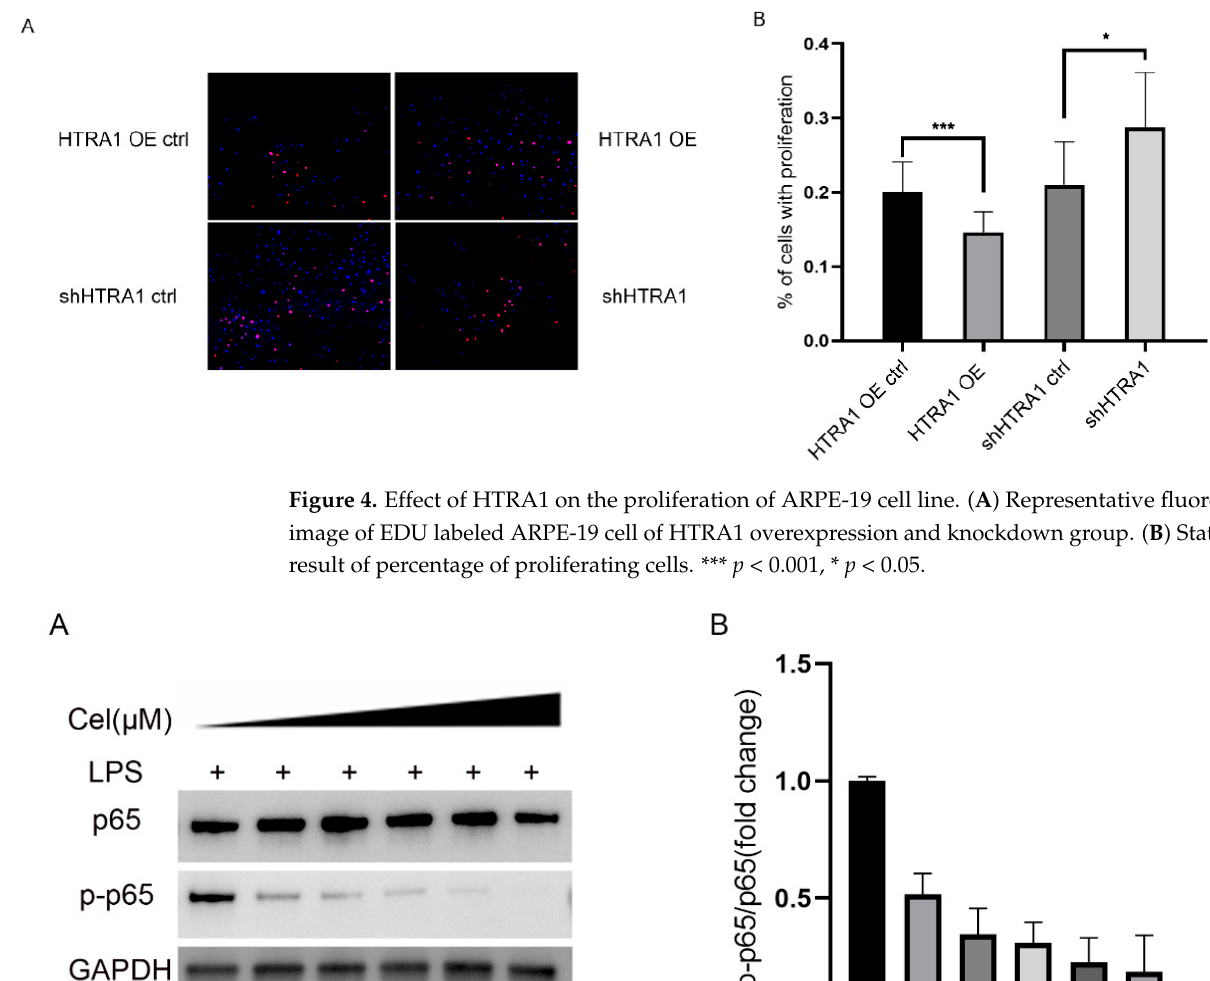
Figure 4. Effect of HTRA1 on the proliferation of ARPE-19 cell line. ( A ) Representative fluorescent image of EDU labeled ARPE-19 cell of HTRA1 overexpression and knockdown group. ( B ) Statisti- cal result of percentage of proliferating cells. *** p <0.001, * p <0.05.